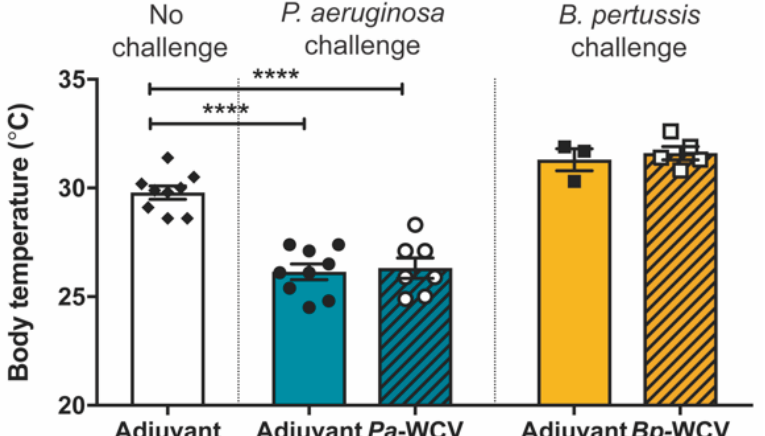
Figure 2. Challenge with P. aeruginosa , but not B. pertussis , reduces the body temperature of challenged animals, compared to adjuvant-vaccinated, non-challenged animals. Body temperatures were measured using infrared thermometer aimed at the abdominal region of the animal ( n = 3–10). The asterisks and bars refer to statistical significance determined by ANOVA with multiple comparisons: **** p ≤ 0.001.